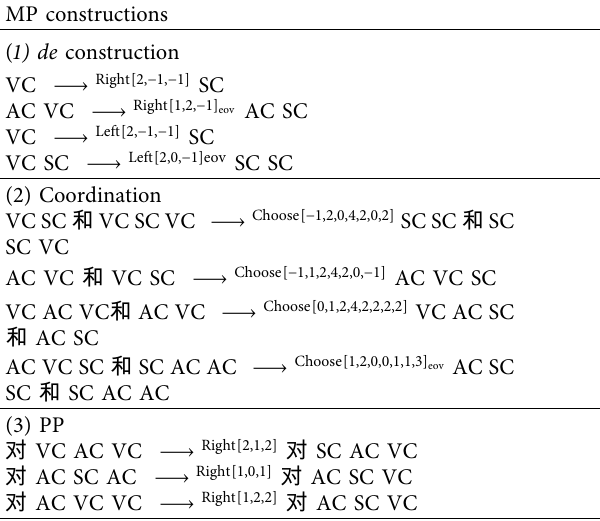
Table 10: Partial projection requirements for MP constructions.